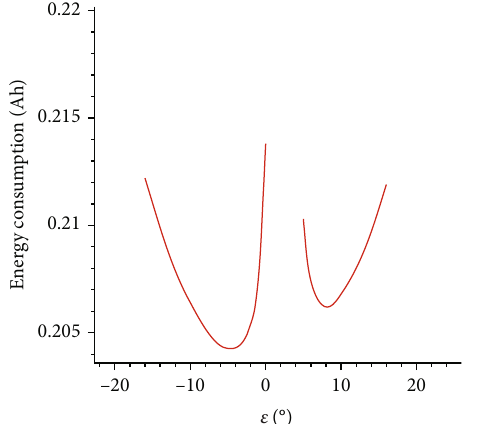
Figure 41: The energy consumption of the Quad-Plane under 5.6m/s wind disturbance in